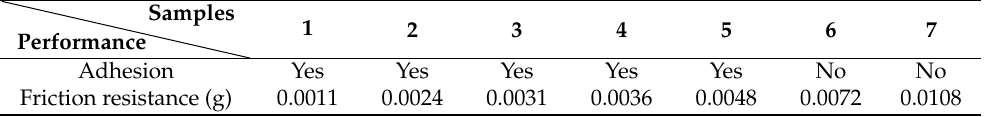
Table 1. Adhesion and friction resistance of coatings prepared with different epoxy group molar ratio E51: ED.